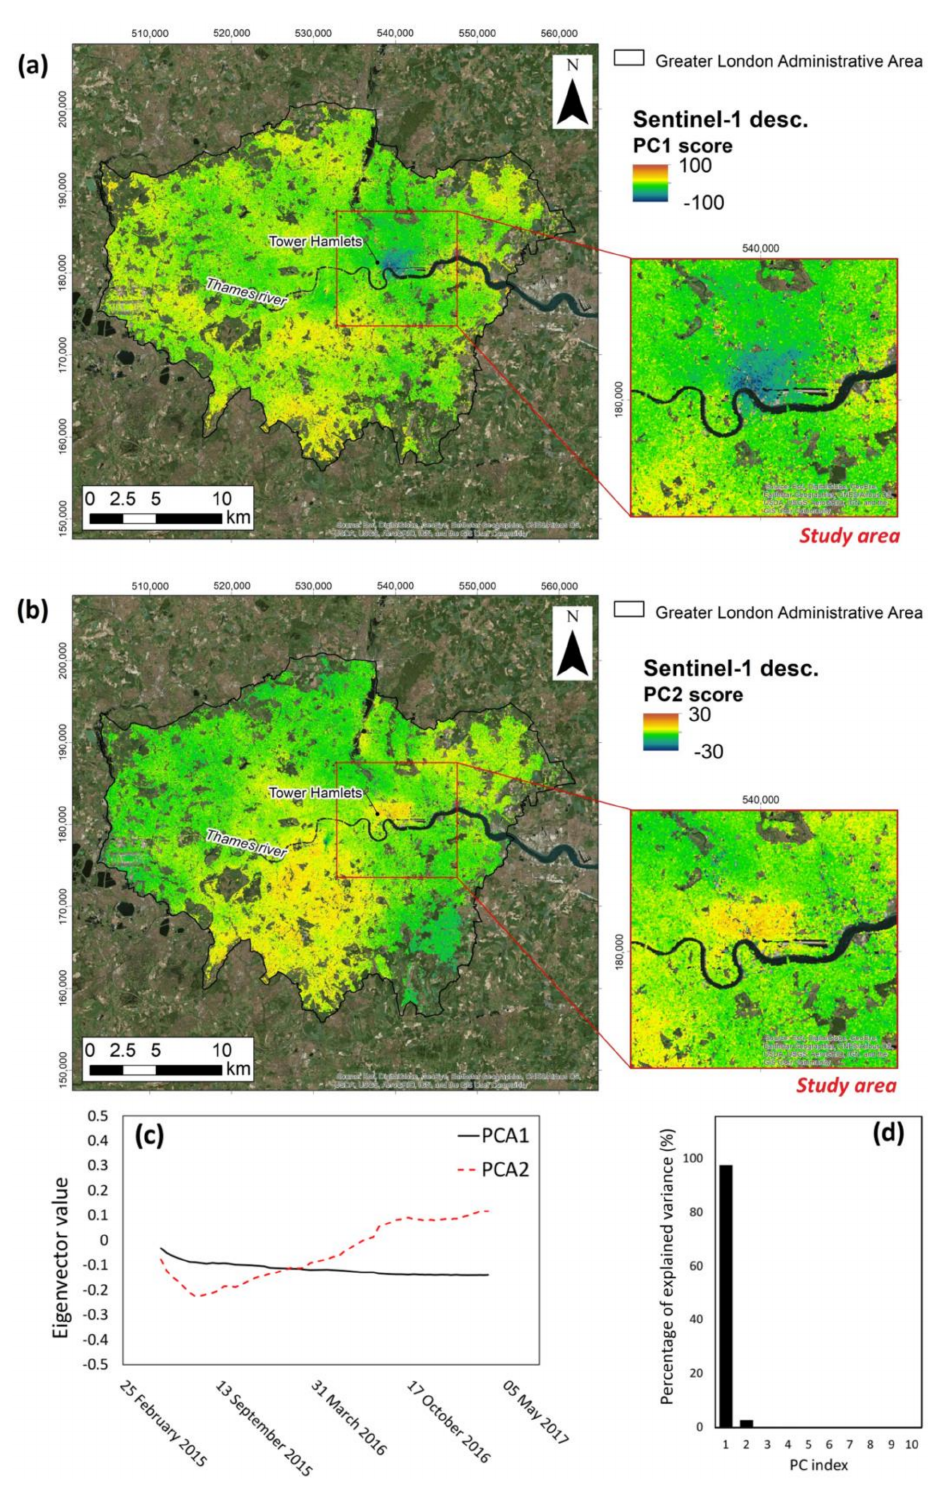
Figure 6. Principal component score maps of the first ( a ) and second ( b ) component of motion. Eigenvector value ( c ) of the principal component (PC) and the percentage of explained variance ( d ) are also